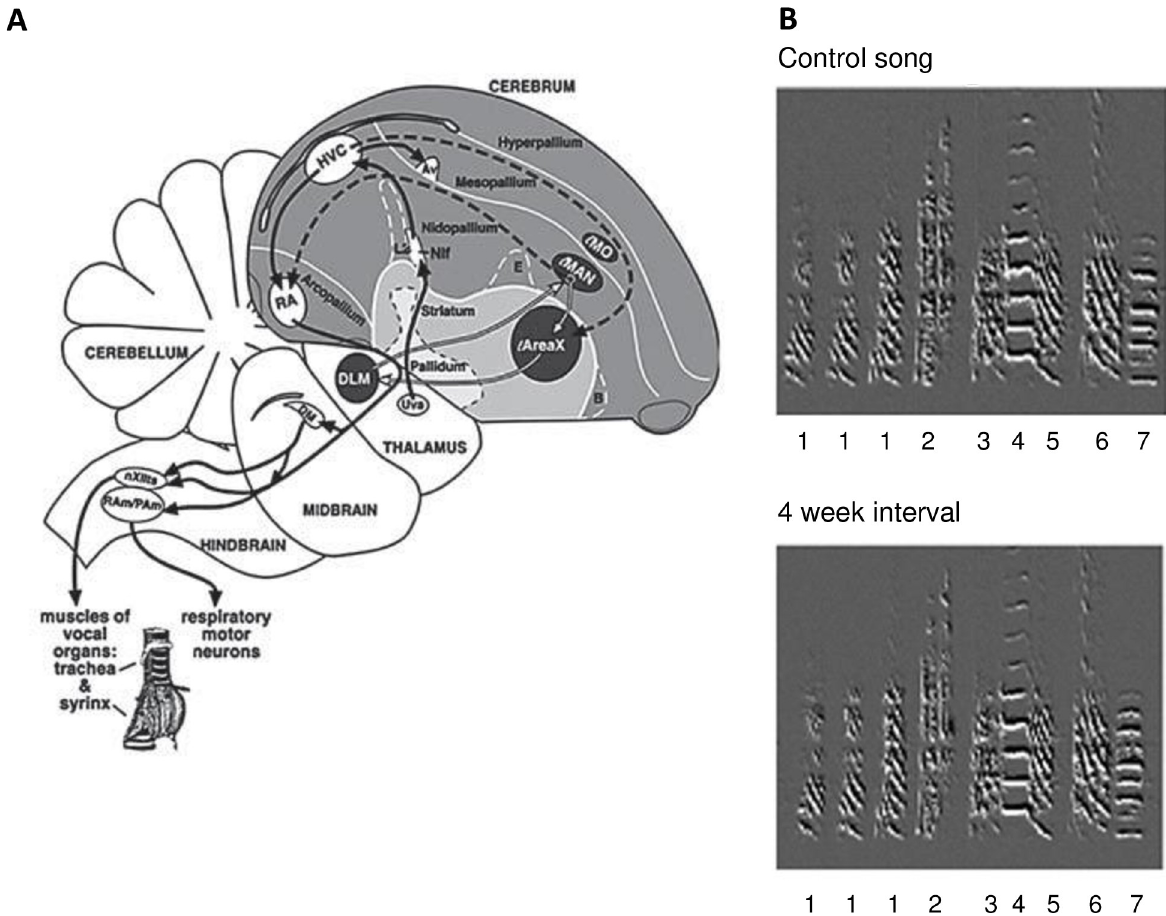
Fig 1. Song system and song stability. A. Diagram of the song system in a sagittal section, showing the vocal motor pathway (black solid lines) and the anterior forebrain pathway (dashed and white lines). White lines show the feedback loop between the striatum, thalamus, nidopallium, and projection back to the striatum. AV = Nucleus avalanche; B = nucleus basorostralis; DM = dorsal medial nucleus; DLM = dorsal lateral nucleus of the medial thalamus; E = entopallium; LMAN = lateral magnocellular nucleus of the anterior nidopallium; LMO = lateral oval nucleus of the mesopallium; Nif = interfacial nucleus of the nidopallium; PAm = para-ambiguus; Ram = nucleus retroambiguus; Uva, nucleus uvaeformis; nXIIts = tracheosyringeal portion of the hypoglossal nucleus. Reproduced from Pytte et al. (2011) [42]; syrinx modified from Goller and Suthers (1996) [62]. B. Spectral derivatives of a song motif generated with Sound Analysis Pro 2011 [56] showing example song stability over a 4 week interval in a young adult bird (5 mos old). Numbers identify different song elements based on qualitative assessment of acoustic structure, shown here to highlight similarity of structure in the two recordings; number “1” is a repeated introductory syllable. Modified from Pytte et al., (2012) [65].